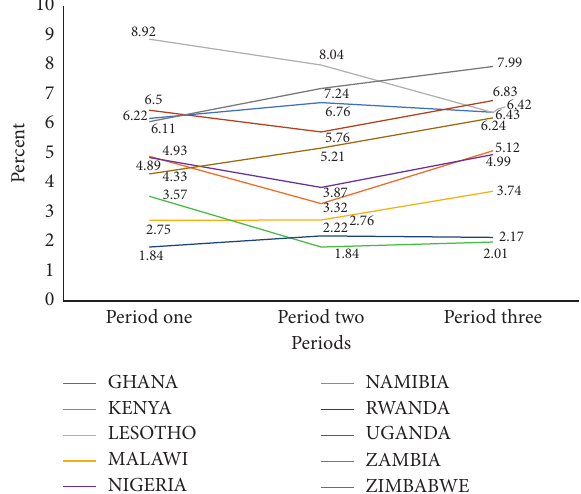
Figure 1: Trend of higher-risk sexual behavior across periods for each country.